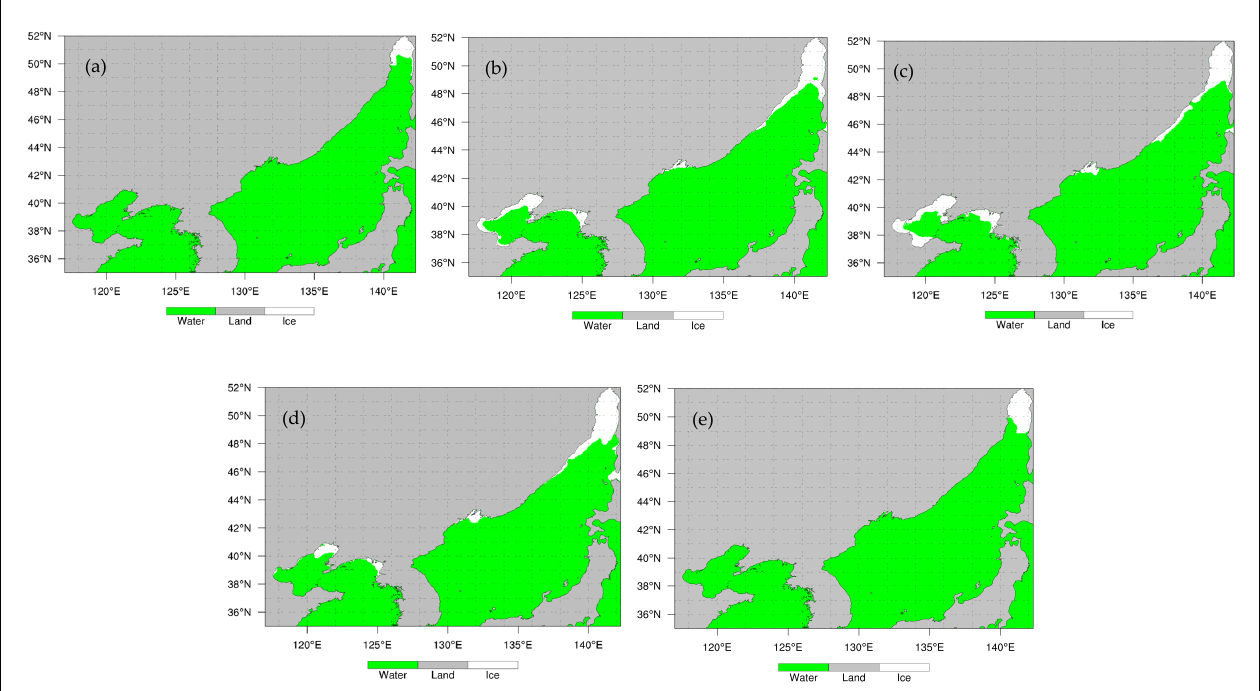
Figure 3. Spatial distribution of sea ice extents in the different stages of a start ( a ), increase ( b ), peak ( c ), decrease ( d ) and disappearance ( e ) in the marginal seas of East Asia.